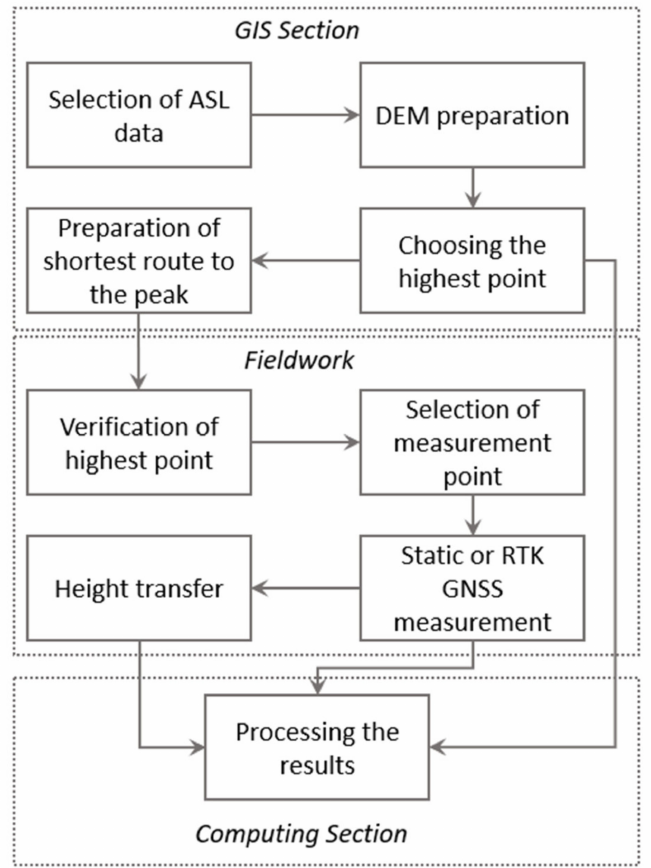
Figure 7. Scheme of the planned analytical and measurement